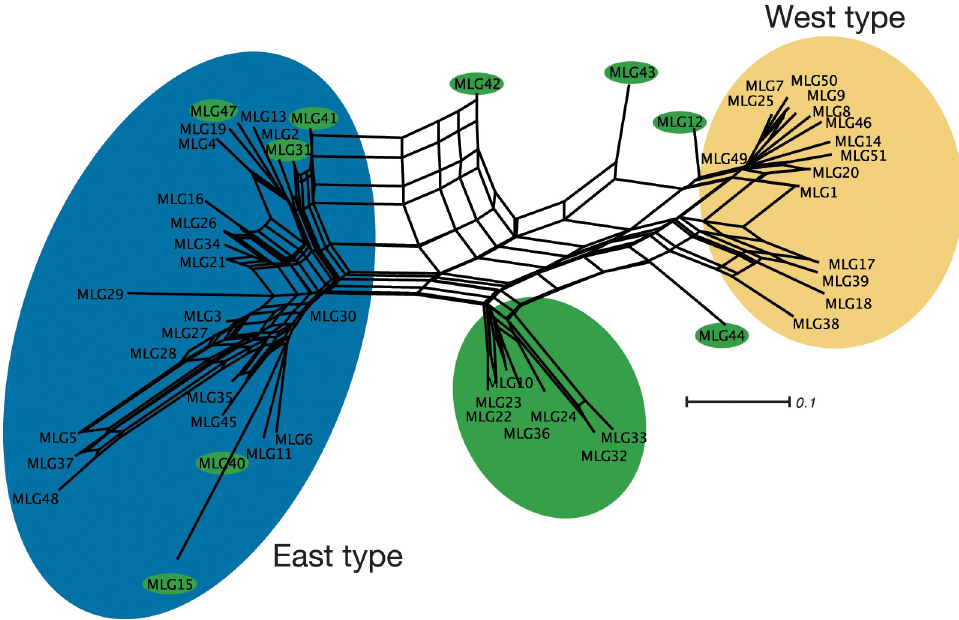
Fig 4. Neighbor-net analysis for multilocus genotypes. Blue-, yellow- and green-coloured MLGs indicate MLGs of the East-type, the West-type, and hybrids or recombinants between the East- and West-types.